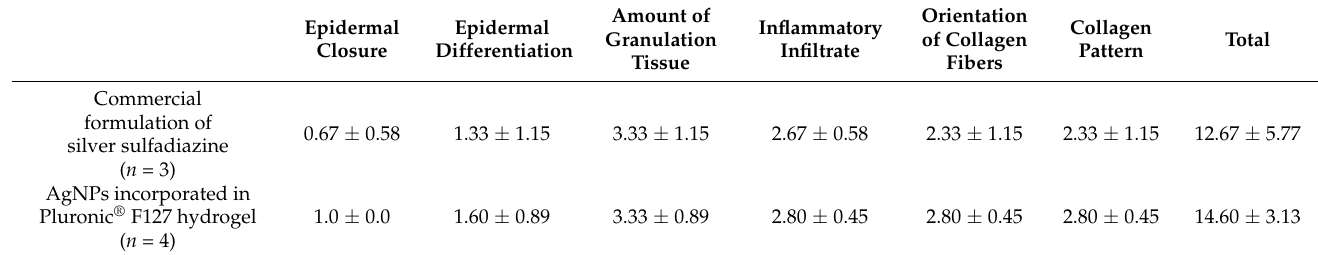
Figure 11. Histological section images of the skin of the mice after 5 days of treatment with ( A , C ) commercial cream of silver sulfadiazine (10 mg/g), and ( B , D ) AgNPs incorporated in Pluronic ® F127 hydrogel (66 nM). ( A , B ) Magnification 10× and ( C , D ) magnification 20×. Table 4. Scoring of skin regeneration following 5 days of treatment, as follows: epidermal clo- sure (0—ulcerated skin, 1—closed wound), epidermal differentiation (0—absent, 1—spinous epi- dermal, 2—granular layer), amount of granulation tissue (1—profound, 2—moderate, 3—scanty, 4—absent), presence of inflammatory infiltrates (1—plenty, 2—moderate, 3—few), the orientation of collagen fibers (1—vertical, 2—mixed, 3—horizontal) and collagen pattern (1—reticular, 2—mixed, 3—fascicle)